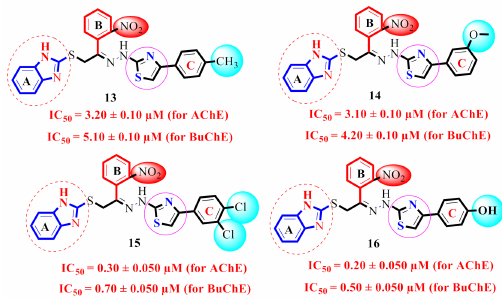
Figure 8. SAR study of scaffolds 13 – 16